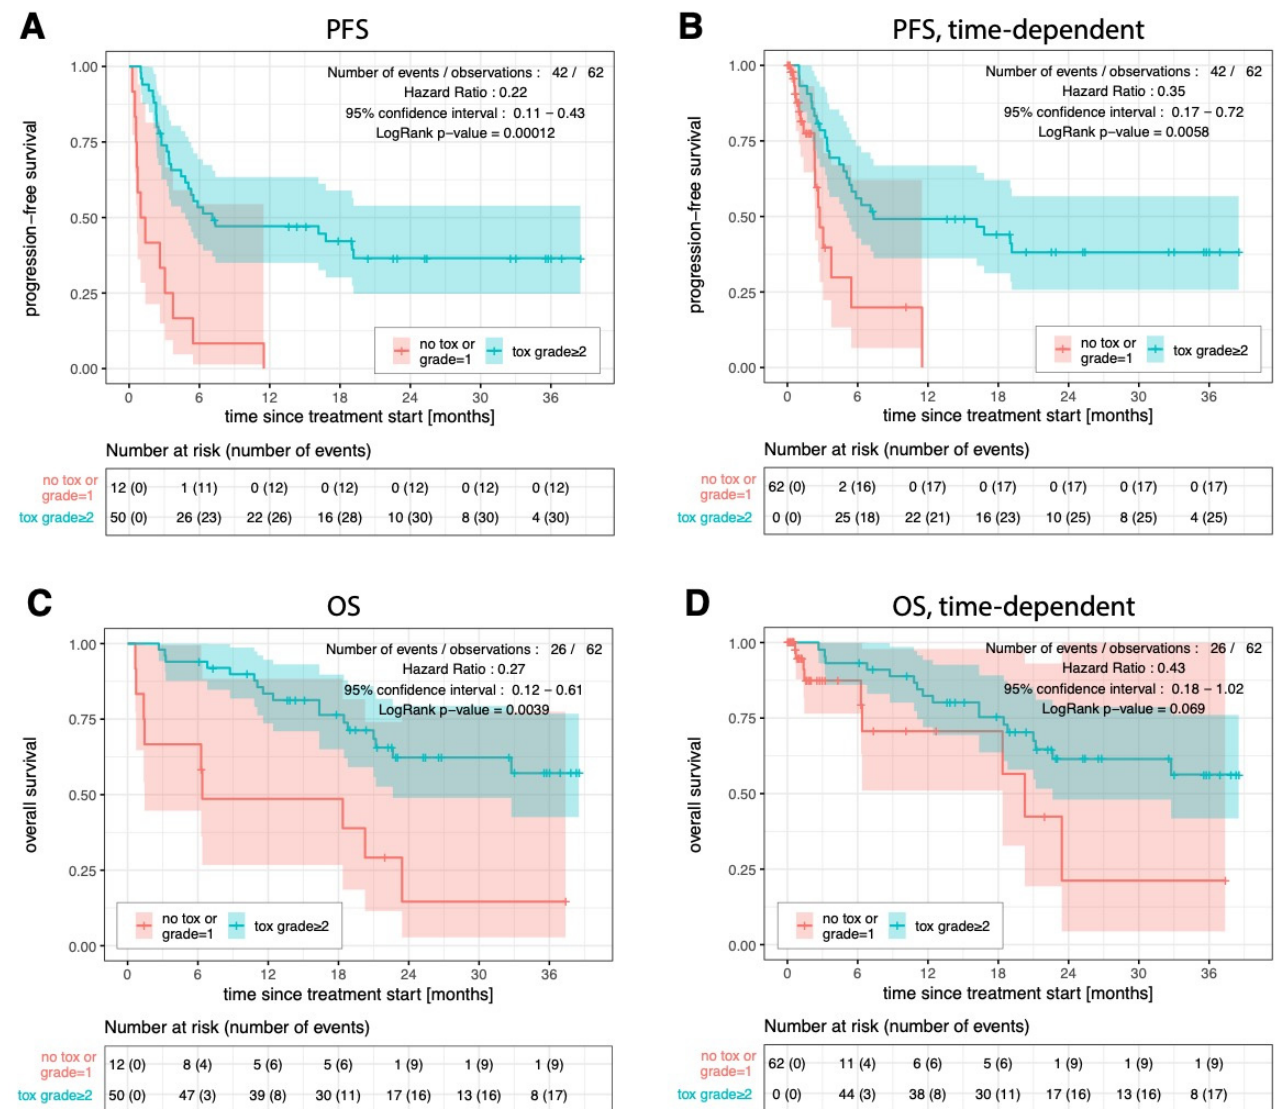
Figure 3. Progression-free survival considering the occurrence of toxicities of Grade ≥ 2 as a fixed covariate ( A ) or as a time-dependent covariate ( B ). Overall survival with fixed ( C ) or time-dependent ( D ) covariate. Kaplan–Meier and Cox regression analyses were performed in R v4.0.3 [19], using the survival and survminer packages. The log-rank test was used to determine statistical significance of survival curve dissimilarity.